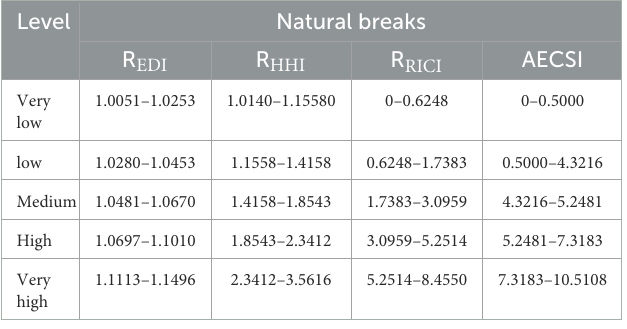
TABLE 1 Natural breaks of different risk levels in 2019.